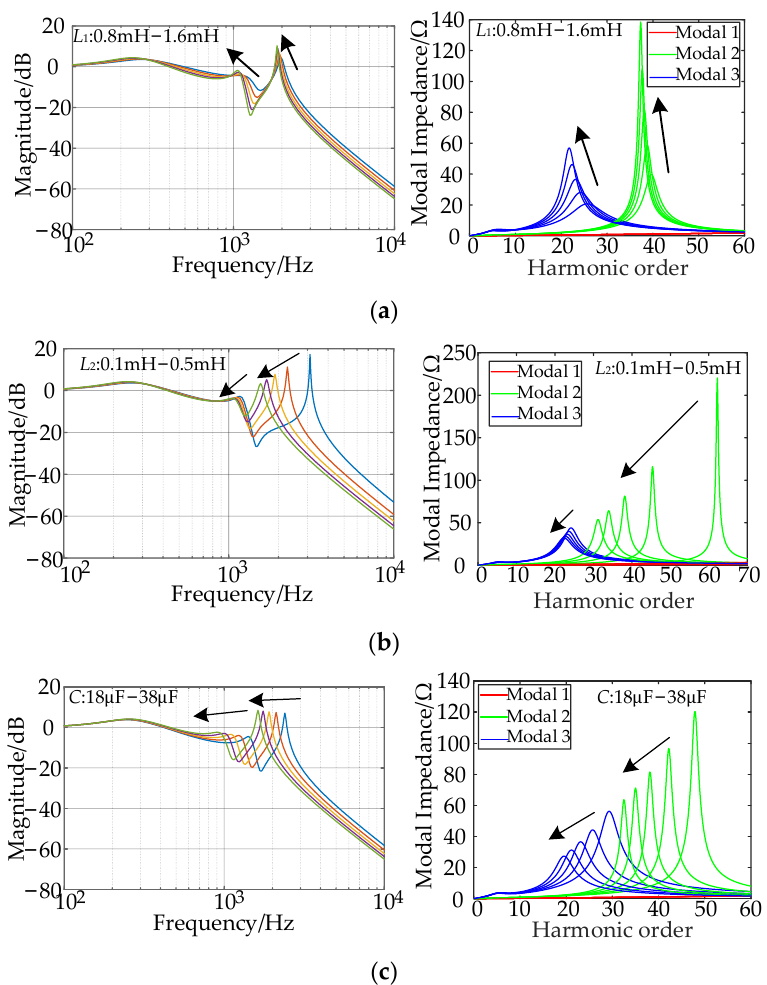
Figure 13. The resonance characteristics curve when the LCL parameters are changed: ( a ) L 1 ; ( b ) L 2 ; ( c ) C